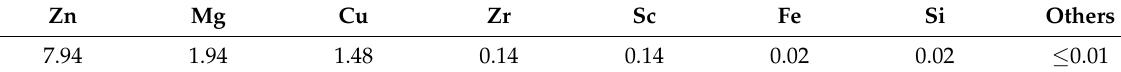
Table 1. Practical chemical composition of the test alloy (wt. %).